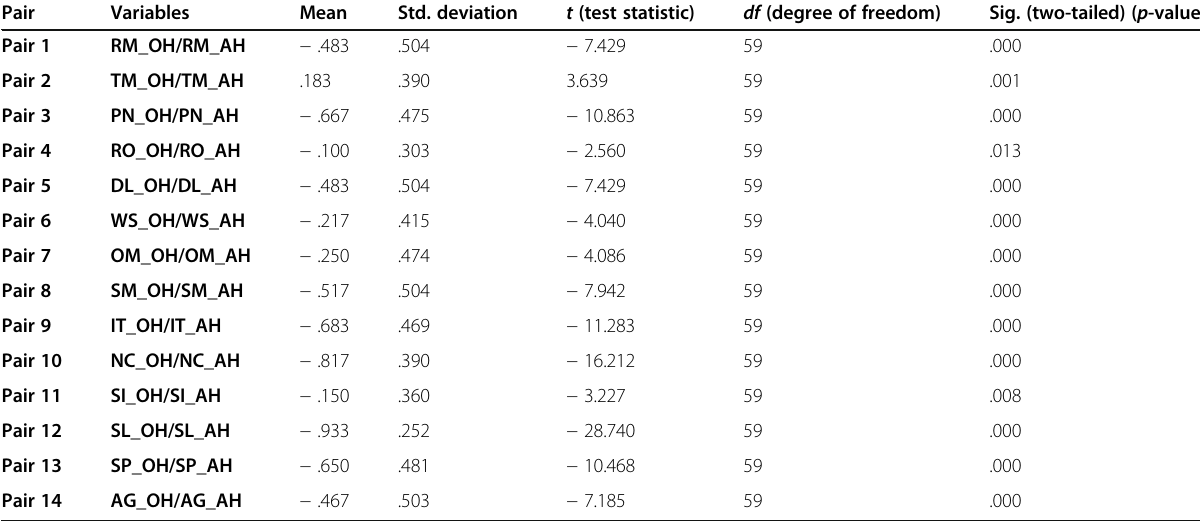
Table 3 Paired samples t -test results of characteristics in old vs RA affected handwriting